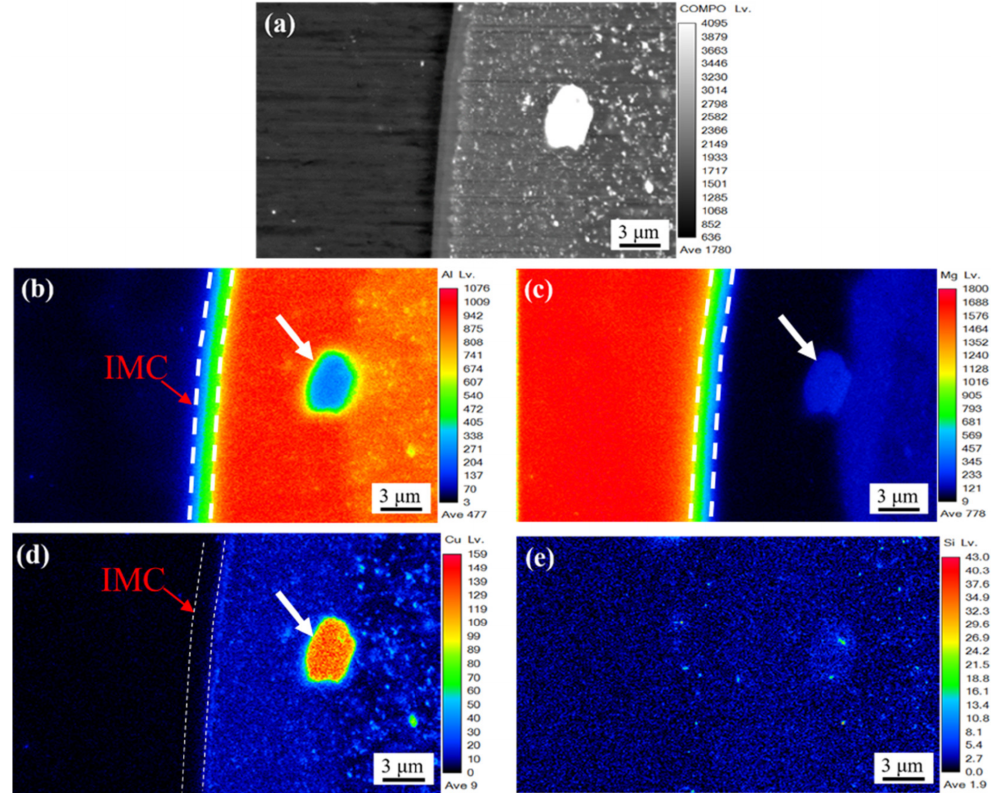
Figure 5. EPMA scanning at location BOT ( a ), distribution map of Al ( b ), Mg ( c ), Cu ( d ), and Si ( e ).